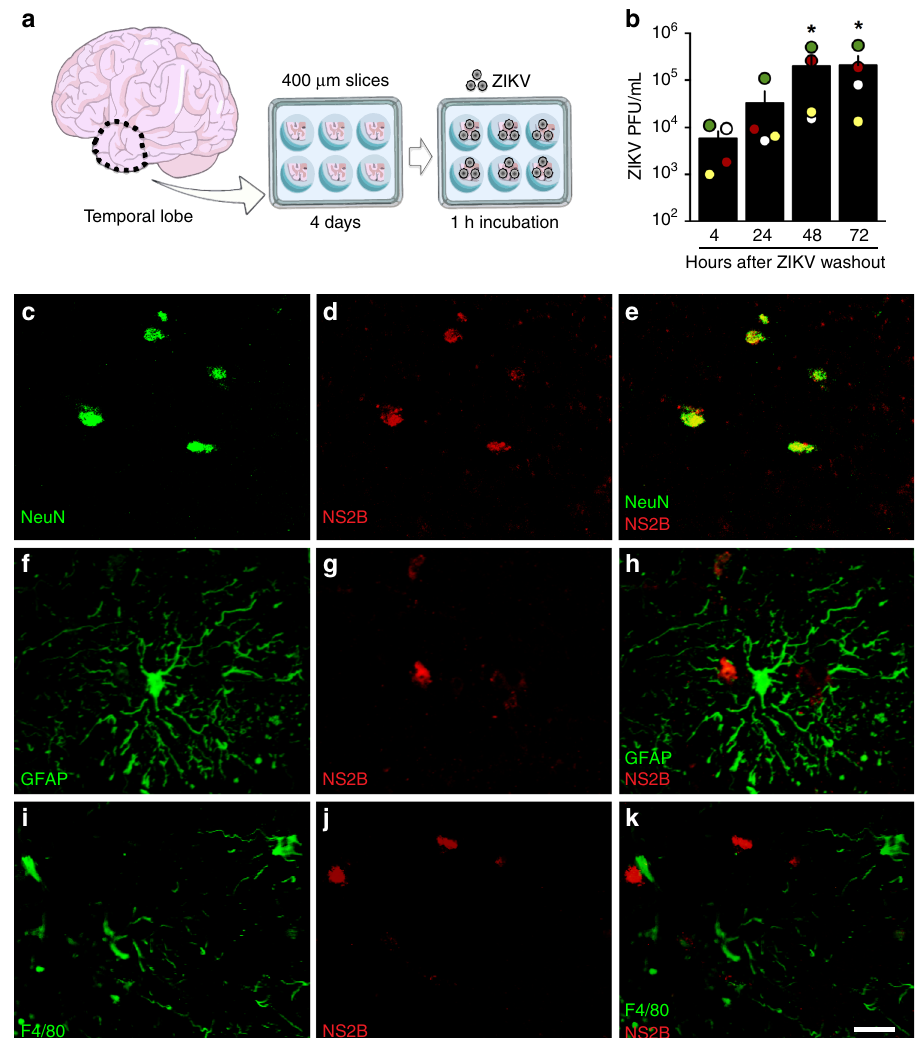
Fig. 1 ZIKV replicates and targets neurons in adult human cortical tissue. a Human temporal lobe cortical tissue fragments were sectioned into 400 µ m slices and maintained in culture for 4 days prior to incubation with ZIKV (10 7 PFU) or mock medium for 1 h, followed by washout. Slices were used for immunohistochemistry, and culture medium was collected for determination of virus titers. b Quantitation of infectious viral particles in the culture medium by plaque assay. Bars represent means± SEM. Symbols represent means of duplicate or triplicate determinations from four independent human donors (shown in different colors) at each time point. (* p = 0.0411, input (4 h after washout) vs 48 or 72 h after washout; Friedman followed by Dunn ’ s post-test). c – k Representative images of double immuno fl uorescence labeling for ZIKV (NS2B protein, red) and NeuN (green) ( c – e ), GFAP (f – h), or F4/80 ( i – k ) in ZIKV -infected human tissue slices from two independent donors. Scale bar = 50 μ m. Source data from panel b are provided as Source Data